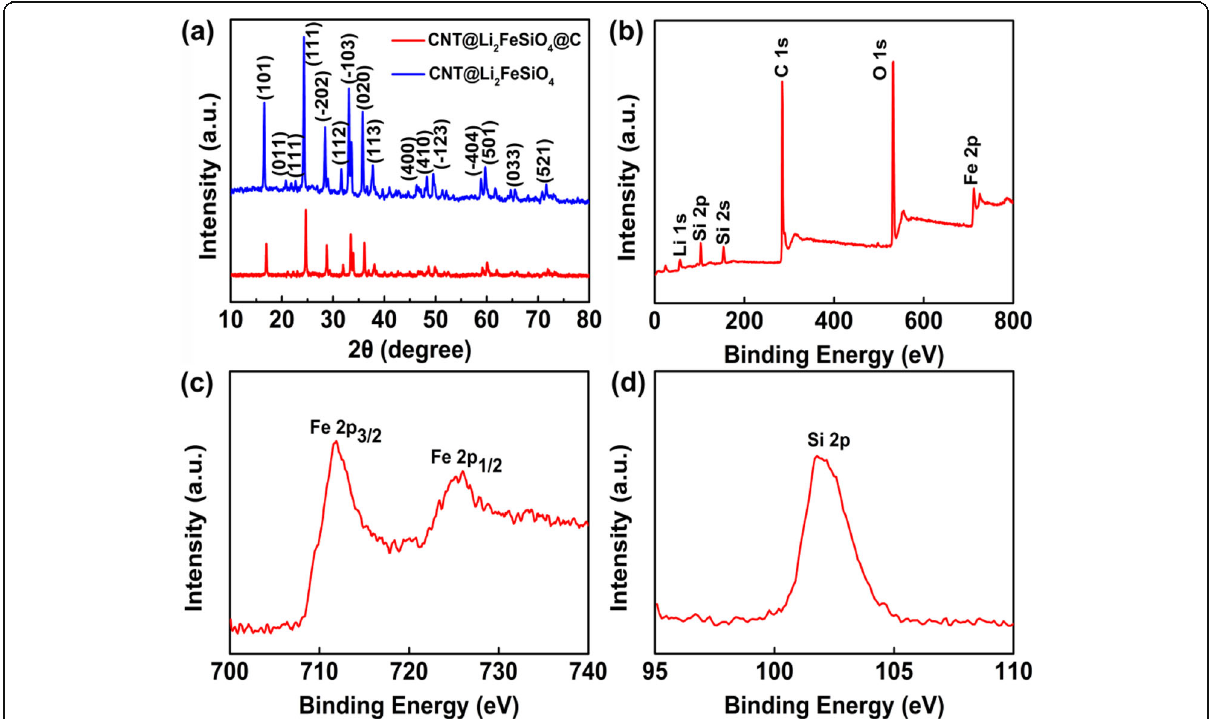
Fig. 2 a XRD of CNT@Li 2 FeSiO 4 and CNT@Li 2 FeSiO 4 , b XPS full spectra of CNT@Li 2 FeSiO 4 @C, and high-resolution spectra of c Fe 2p and d Si